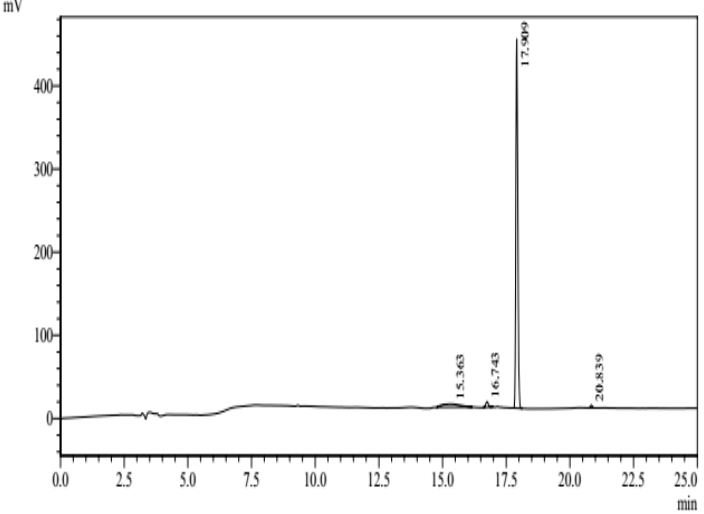
Figure A2. HPLC image of LA ‐ RWR.